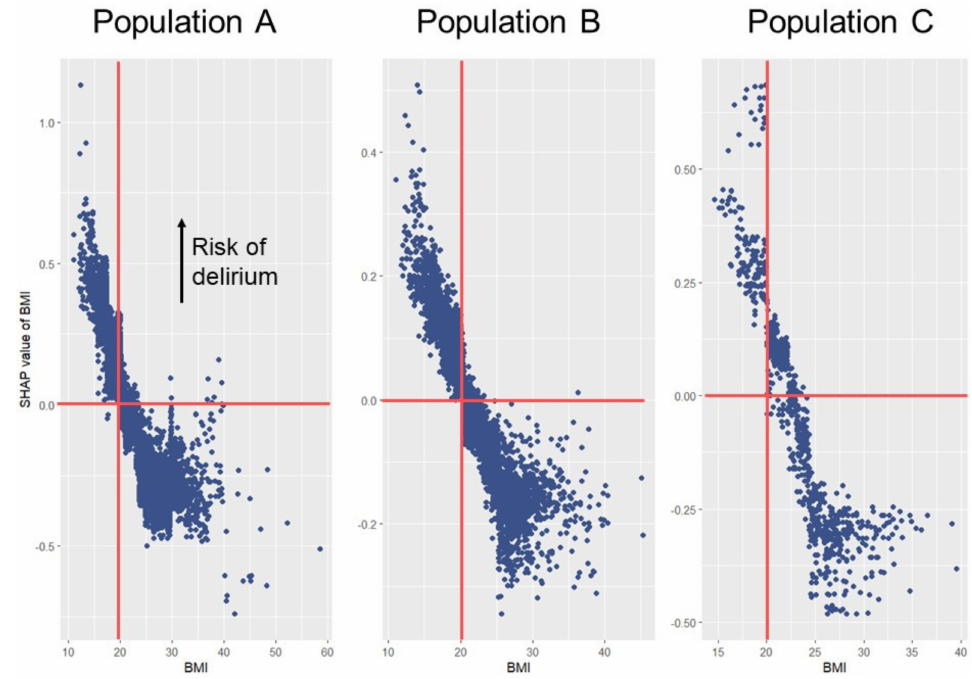
Figure 5. SHAP dependence plot for BMI. Each dot denotes a patient. The x-axis shows the BMI of the patients, and the y-axis shows the SHAP value attributed to the BMI. Higher SHAP values represent higher risk of delirium due to BMI.